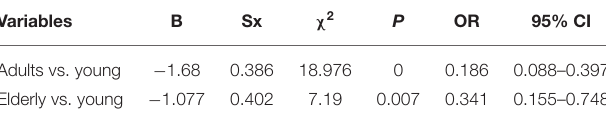
TABLE 7 | Correlation of age with bipolar and unipolar depression in patients who developed the disease in winter (binomial logistic regression analysis).